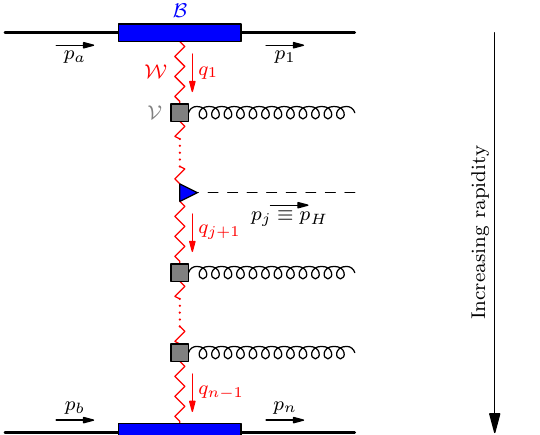
Figure 2. Structure of the matrix element for the process f a f b → f a · · · H · · · f b